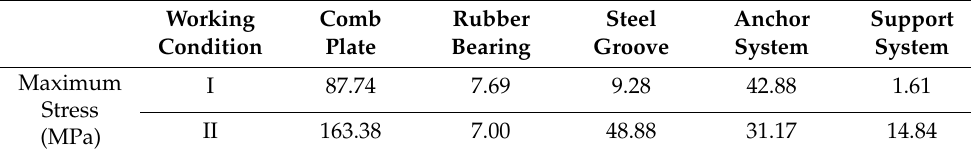
Figure 13. Shear stress diagram of the structure under the working condition II. Table 5. Results of shear stress of the structure under two working conditions.